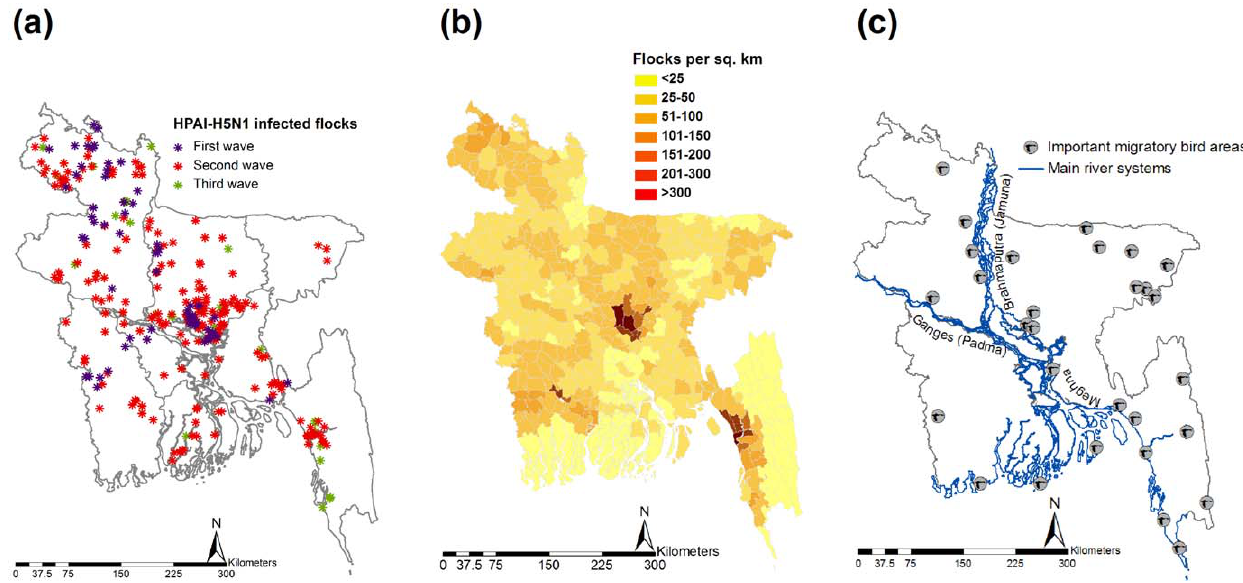
Figure 2. Spatial distribution of (a) HPAI-H5N1 infected flocks in poultry from February 2007 through December 2009; (b) poultry flock density in Bangladesh; (c) known migratory bird winter stopovers in Bangladesh. doi:10.1371/journal.pone.0024324.g002 PLoS ONE |